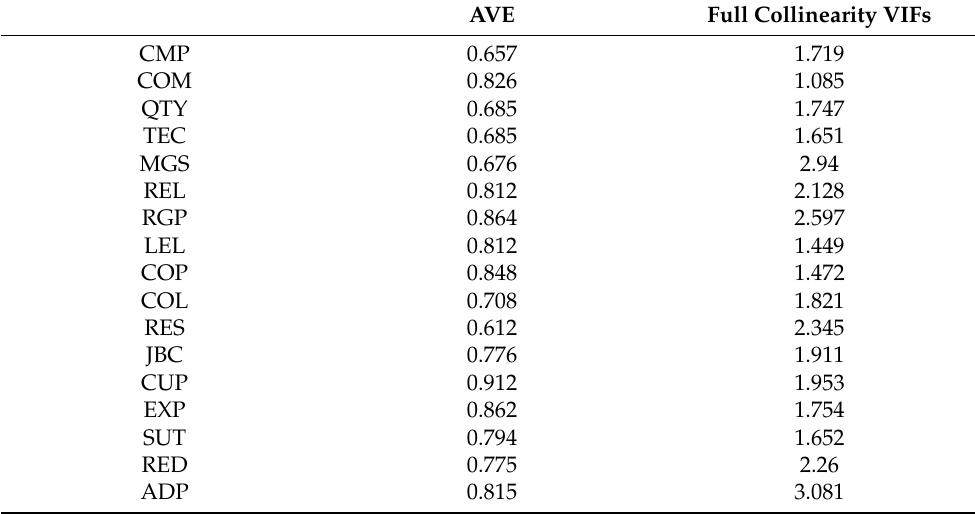
Table 5. Convergent validity